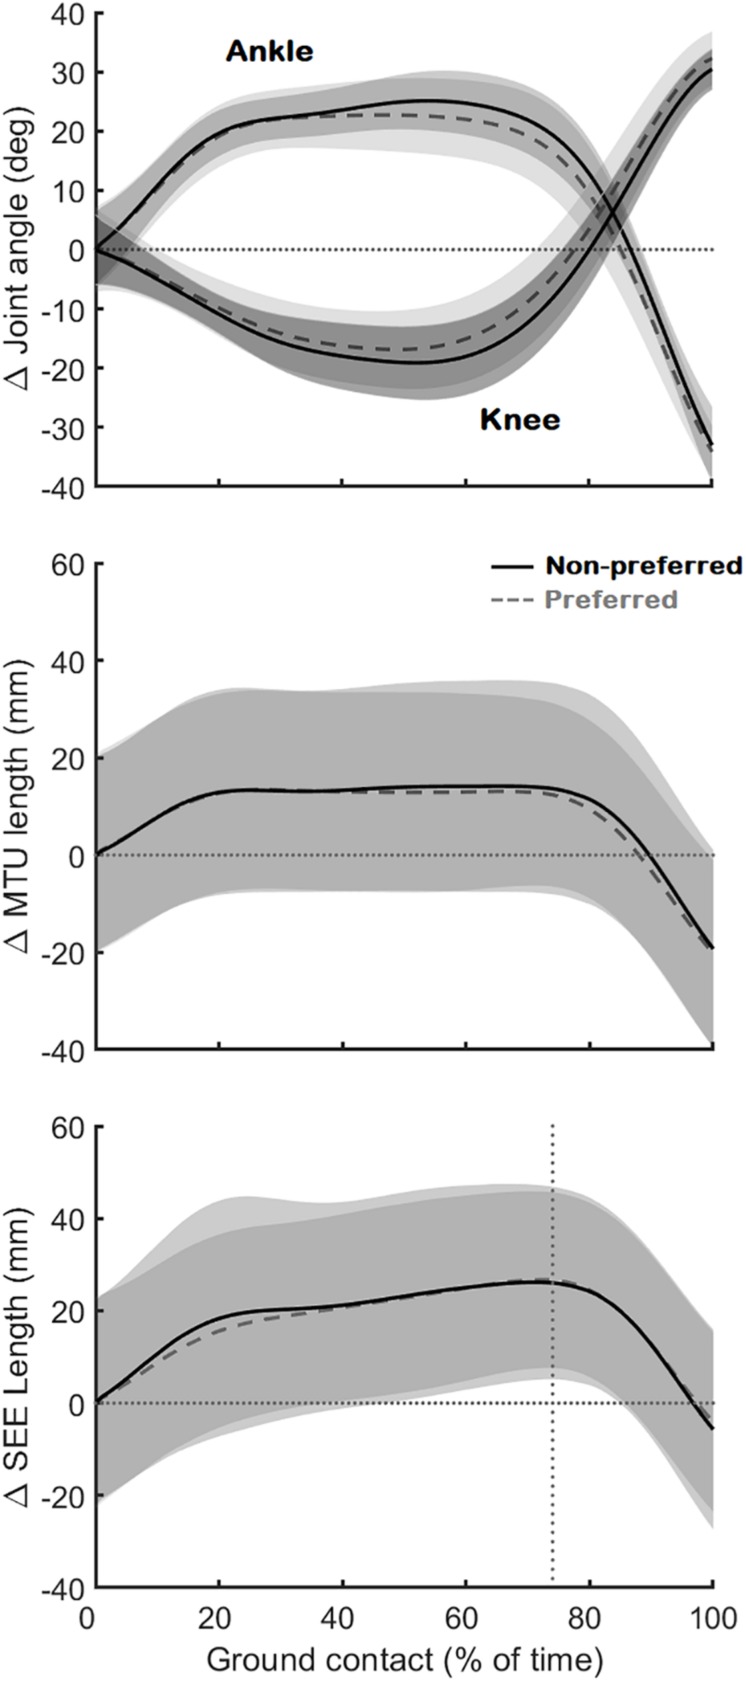
Joint angle changes of the ankle and knee (Top), muscle-tendon unit (MTU) length changes (Middle), and series-elastic element length (SEE) length changes (Bottom). The black continuous line is the average (N = 10) for the preferred leg, the gray dashed line the average (N = 10) for the non-preferred leg. All data is shown as changes relative to the first data point at ground contact (shown as the horizontal dotted lines). The vertical dotted line on the bottom figure shows where the lengthening phase of the series-elastic element stops and the shortening phase begins.